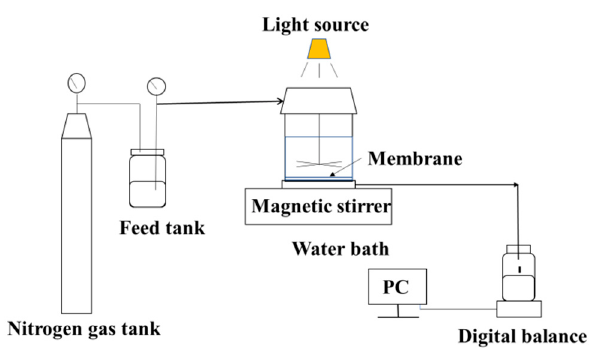
Figure 1. The laboratory self-made flux measurement device diagram.